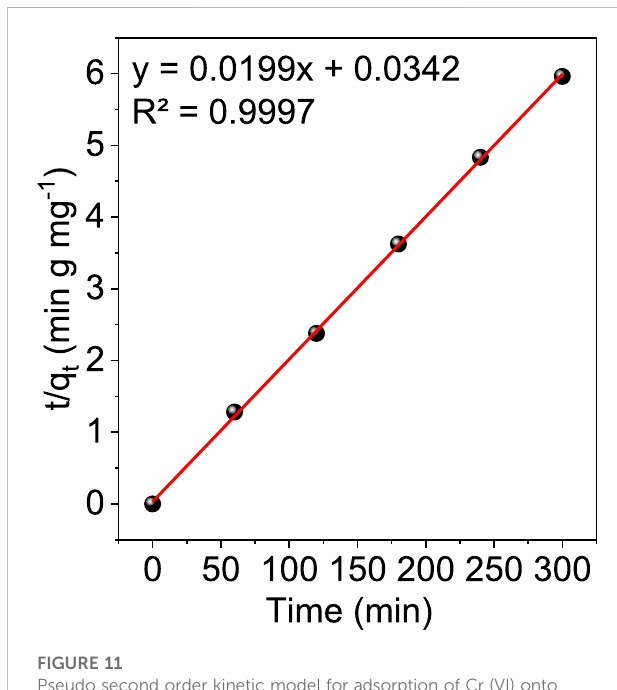
FIGURE 11 Pseudo second order kinetic model for adsorption of Cr (VI) onto GO/ZM